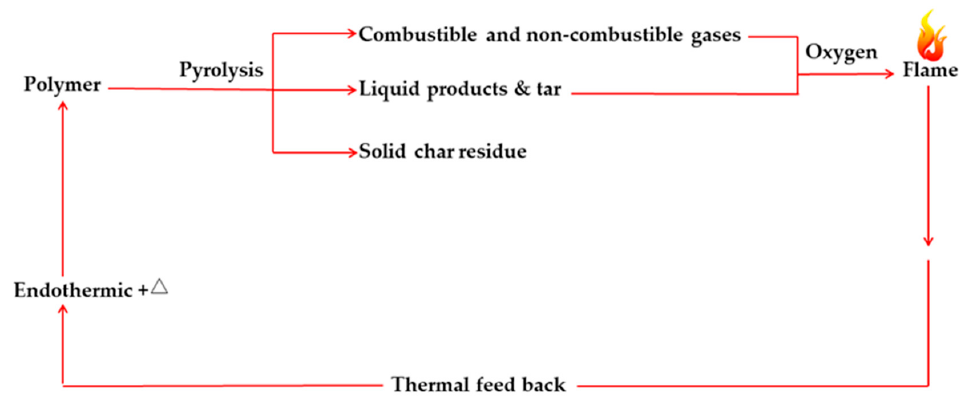
Figure 2. A diagram representation of a polymer combustion cycle.